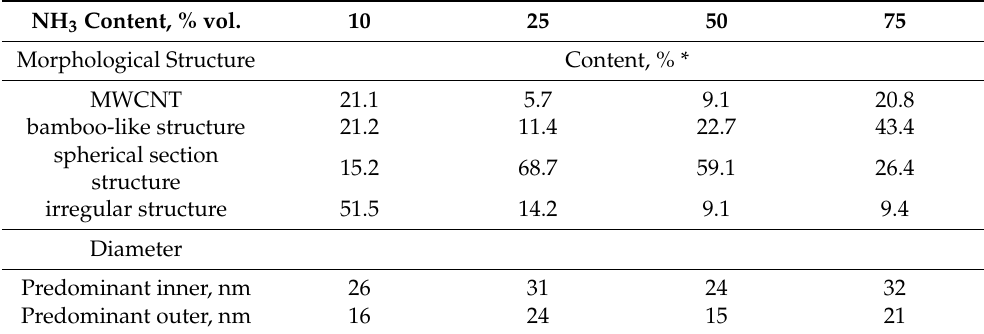
Table 3. Percentage of different morphological structures in the samples obtained at a temperature of 650 ◦ C. NH 3 Content, % vol. Morphological Structure